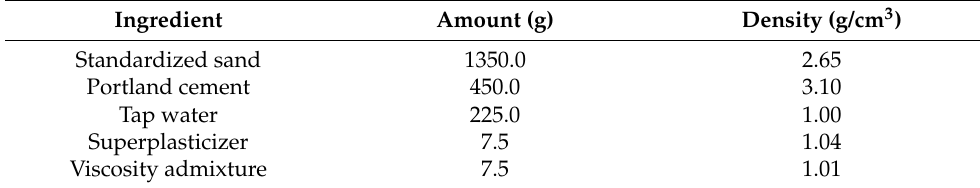
Table 1. Mixture composition of a mortar